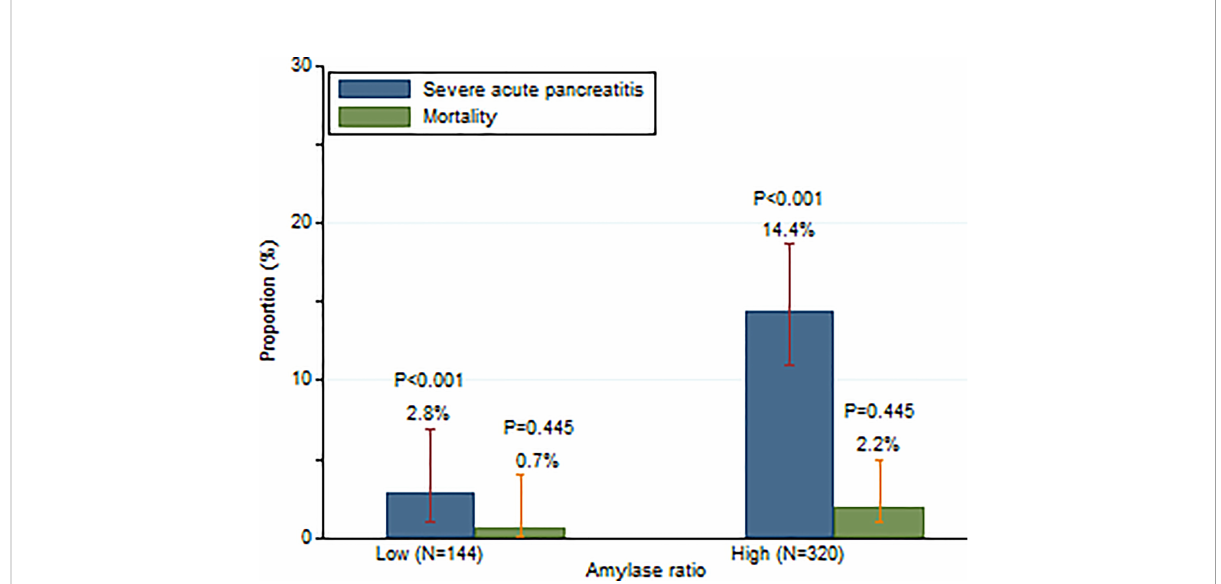
FIGURE 2 Incidence of SAP and mortality in patients with high and low serum amylase day 2/amylase day 1 ratios.